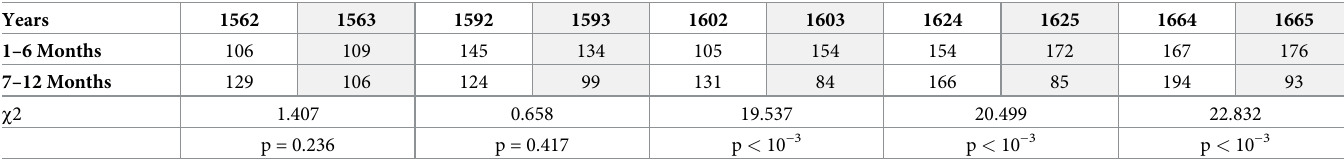
A total of 841 households, spread over the five plague years, were identified by our sampling method. The deaths of husbands and wives were recorded for each household in each of the five plague years and the results are presented in Table 7. The proportion of households Table 6. Baptisms recorded in the first and second halves of plague years compared to those recorded in the non-plague year immediately preceding them. Plague years are indicated by the shaded columns.